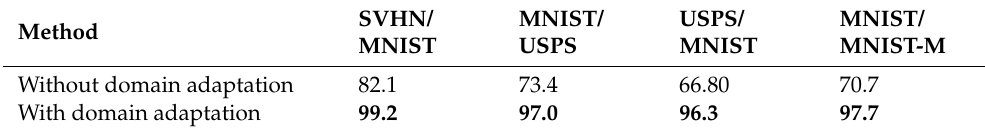
Table 6. Domain adaptation analysis.